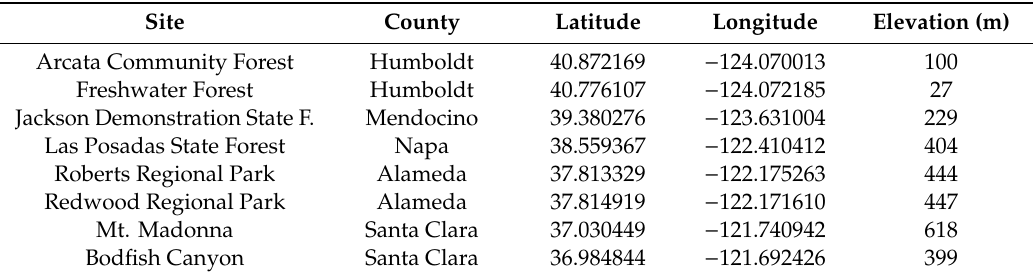
Table 1. Redwood bark thickness study site location information. Site County Latitude Longitude Elevation (m) Arcata Community Forest Humboldt 40.872169 − 124.070013 100 Freshwater Forest Humboldt 40.776107 − 124.072185